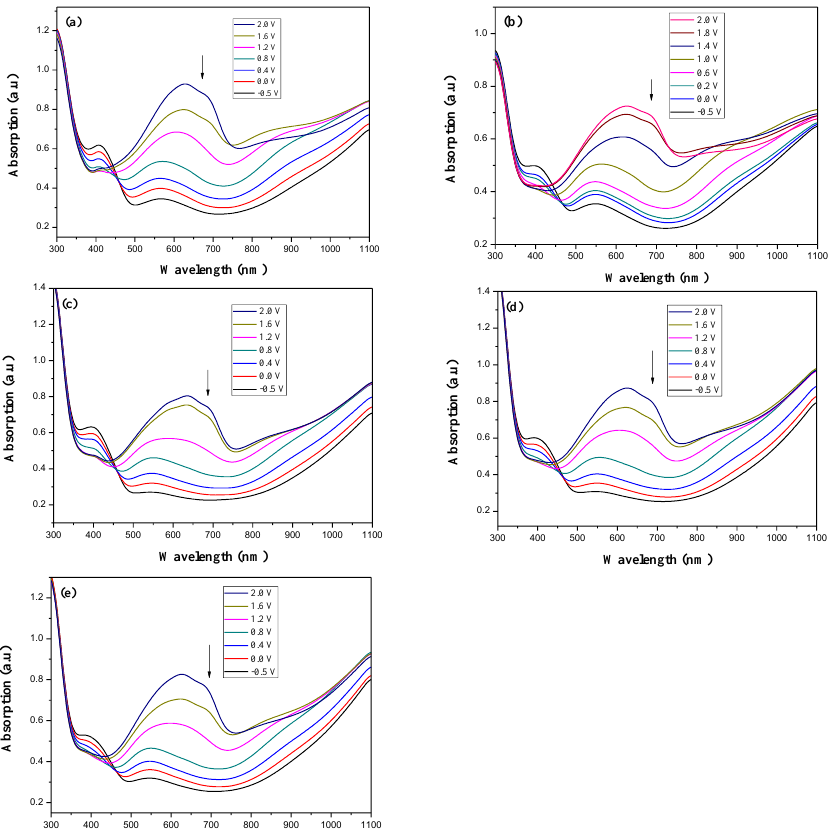
Figure 7. UV-Visible spectra of ( a ) PDTC/PEDOT-PSS, ( b ) P(DTC- co -BTP)/PEDOT-PSS, ( c ) P(DTC-